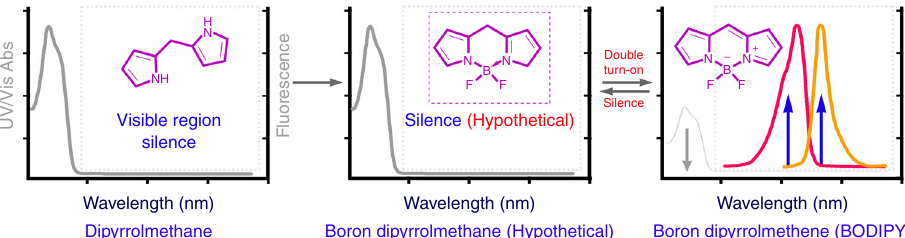
Fig. 1 Hypothetical chemical transformation induced dual signal double turn on process. The boron dipyrrolmethane has neither absorption (colorless) nor fl uorescence in visible region, thus be in a silent state in visible region. But the BODIPY has both strong absorption and fl uorescence in visible region. The transforming from dipyrrolmethane to BODIPY accordingly induces sharp photophysical changes with “ dual signal ” “ double turn-on ”